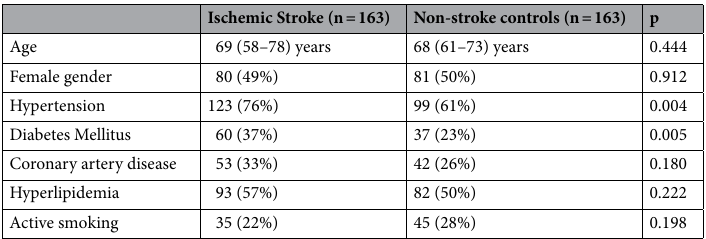
Table 1. Baseline characteristics of the study